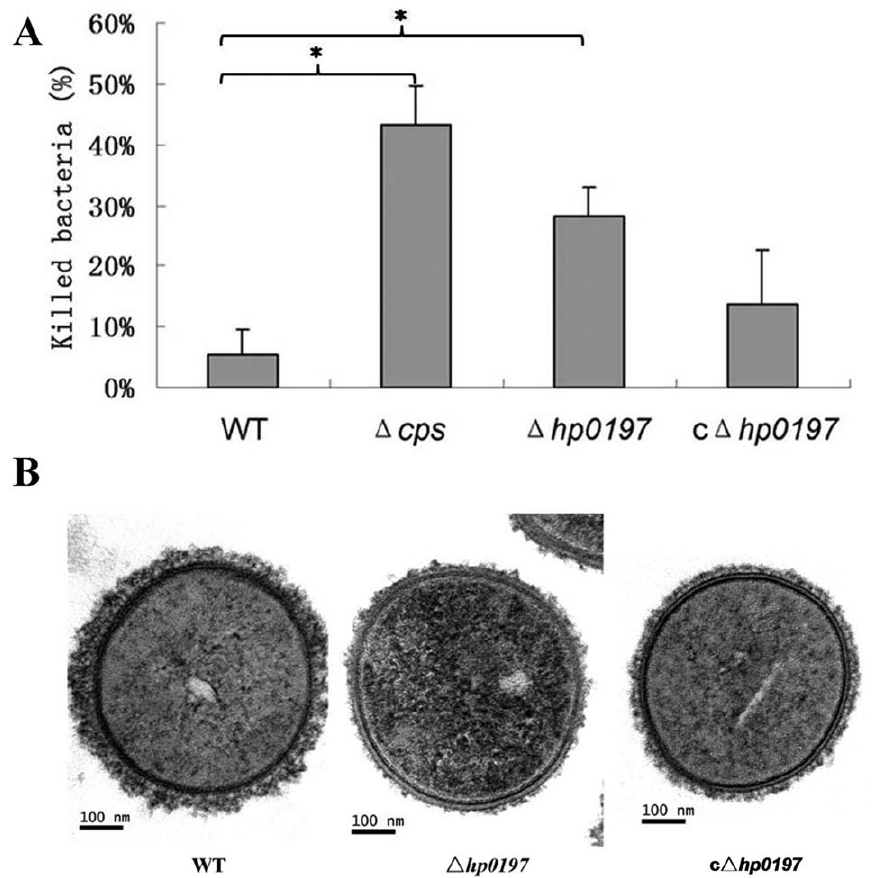
Figure 3. Contribution of hp0197 to the resistance to phagocytotic killing and to CPS synthesis. ( A ) Percent of bacteria killed after 90 min incubation with murine phagocytes. The experiment was repeated five times. Error bars indicate standard deviations. ‘‘*’’ represents P value , 0.05 of WT versus D cps group or WT versus D hp0197 group respectively. ( B ) Morphology of the WT (left), the D hp0197 (middle) and c D hp0197 (right) strains. Transmission electron microscopy revealed that the WT strain was surrounded by a thick polysaccharide capsule (52.8 6 10.4 nm); the thickness of the D hp0197 capsule was markedly reduced (1.1 6 0.3 nm), and c D hp0197 could if not completely, partially restore this phenotype (21.1 6 6.6 nm).